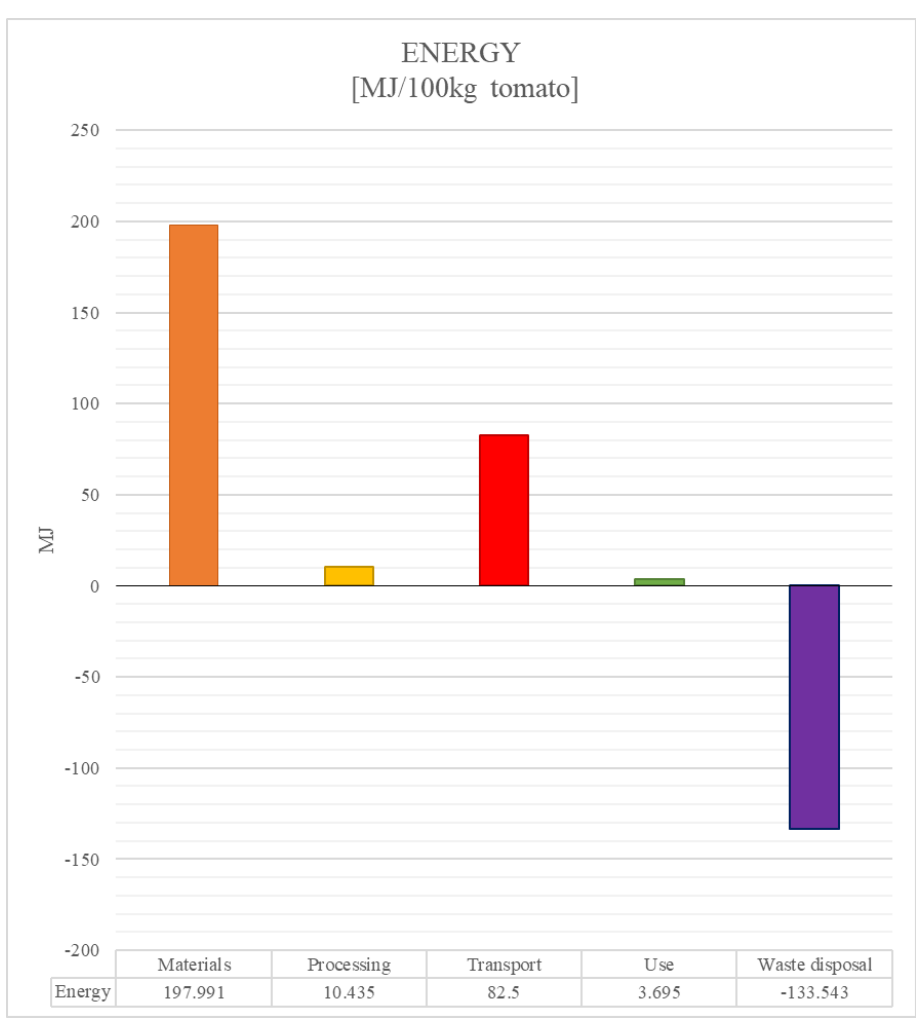
Figure 1. Energy consumption of 100 kg of greenhouse tomatoes per life cycle stage (in MJ).